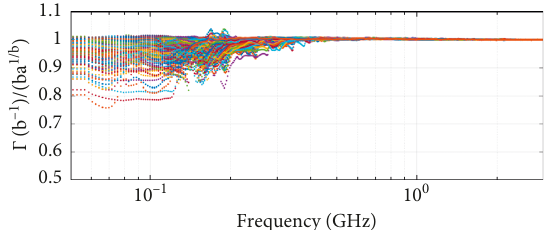
Figure 5: Calculated Γ ( b − 1 ) / ba 1/ b from the estimated ( a,b ) ; points for 324 scenarios are illustrated with different